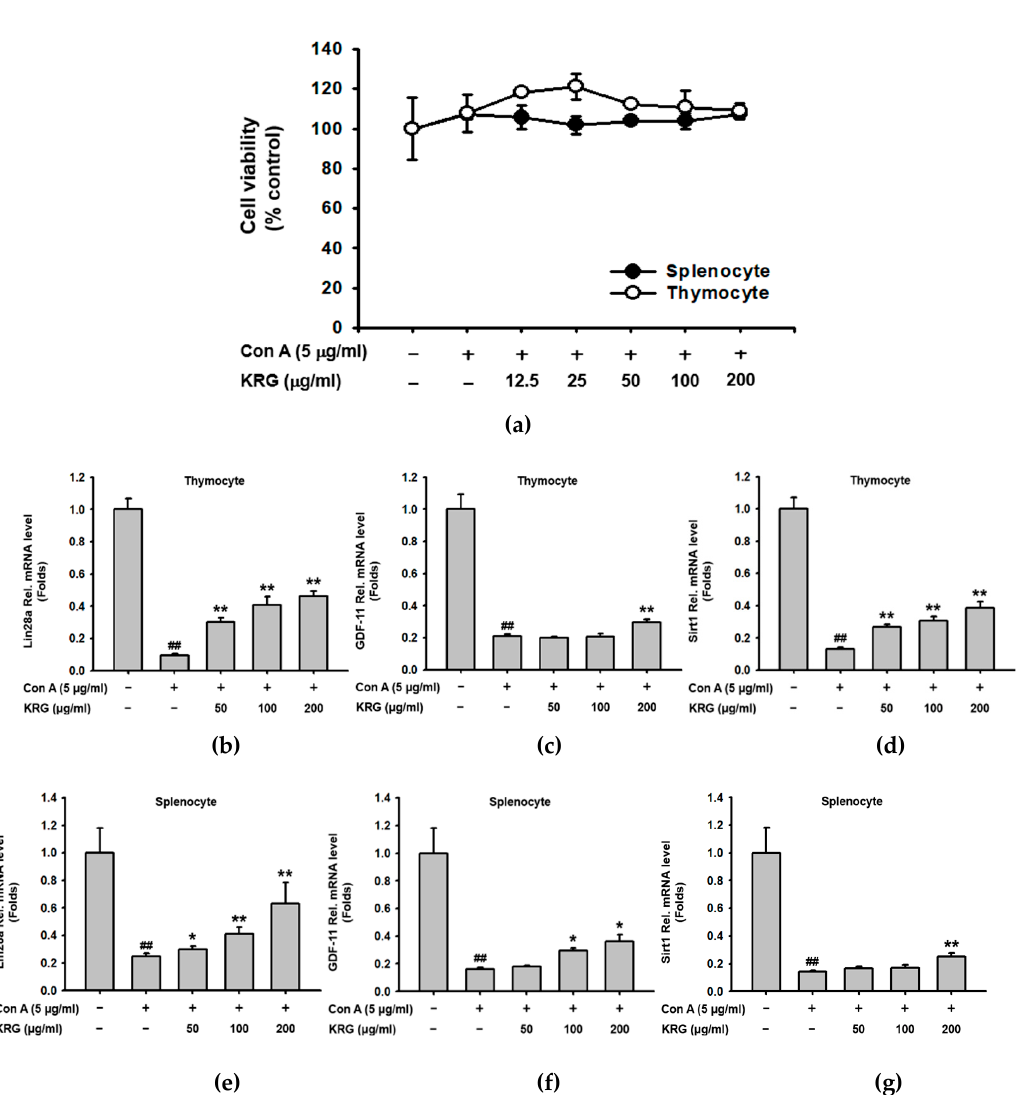
Figure 5. KRG increased the expression of aging-related genes in Con A-stimulated T cells in aged mice. ( a ) Total thymocytes and splenocytes pretreated with Con A (5 μ g/mL) for 30 min were treated with the indicated doses of KRG (0–200 μ g/mL) for 24 h, and cell viability was determined using a conventional MTT assay. ( b–d ) mRNA expression of Lin28a, GDF-11, and Sirt1 genes in the thymocytes of old mice treated with Con A (5 μ g/mL) and KRG (0–200 μ g/mL) for 6 h was determined using quantitative real-time PCR. ( e–g ) mRNA expression of Lin28a, GDF-11, and Sirt1 genes in the splenocytes of old mice treated with Con A (5 μ g/mL) and KRG (0–200 μ g/mL) for 6 h was determined using quantitative real-time PCR. ## p < 0.01 compared to vehicle-treated control cells, and * p < 0.05, ** p < 0.01 compared to Con A-treated control cells.